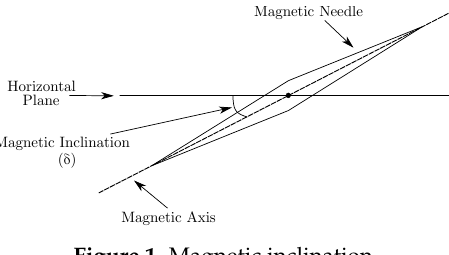
Figure 1. Magnetic